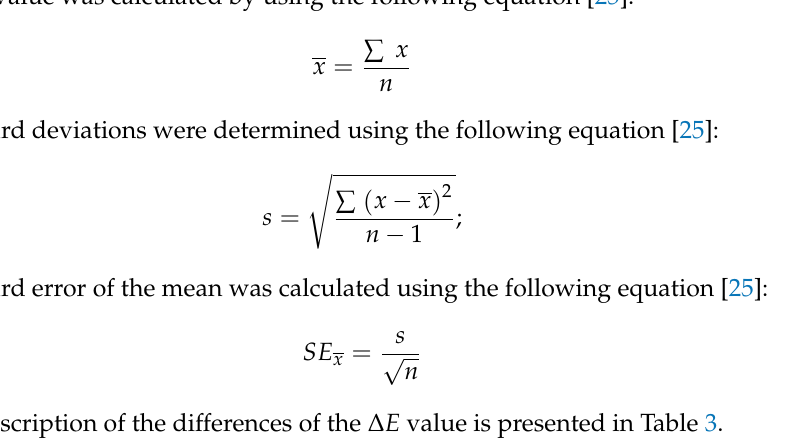
Table 3. Δ E values and their corresponding color differences [26].